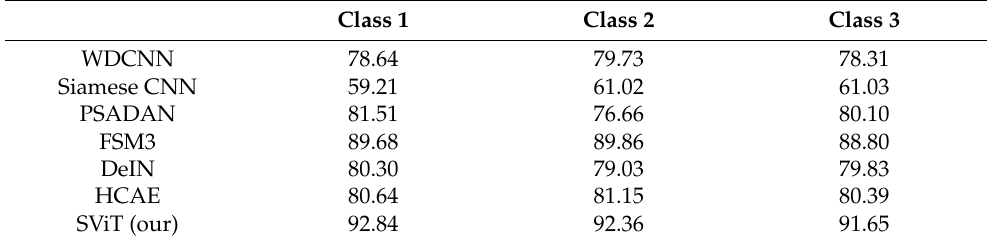
Table 16. Precision (%) comparison for cross-domain task E-D with 1800 training samples per class on the Paderborn dataset.